Question: Summarize what this figure shows in one sentence.
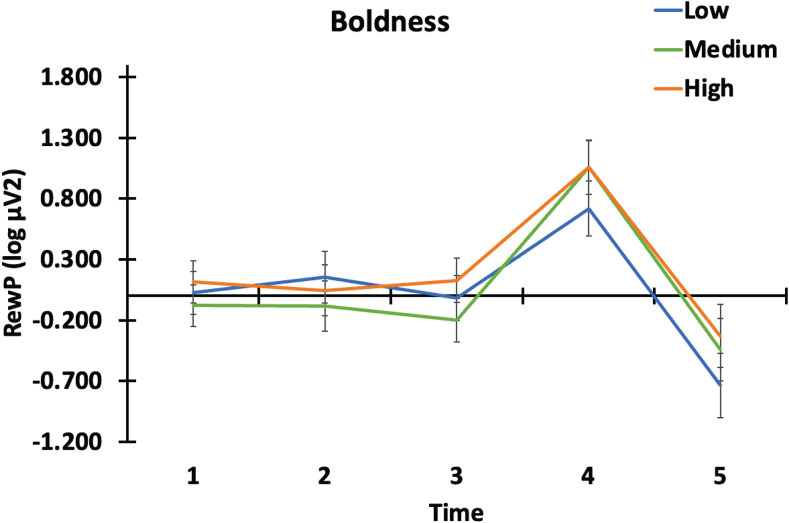
Answer: EEG power of boldness group on RewP . Note: The Y axis represents the EEG (log µV 2 ) for the measure of the GAS – reward positivity (RewP). The X axis presents the time points (ms): 1 = 0–70; 2 = 70–100; 3 = 100–200; 4 = 200–300; 5 = 300–400. Boldness groups are: low (blue); medium (green; and high (orange). Error bars represent standard error.